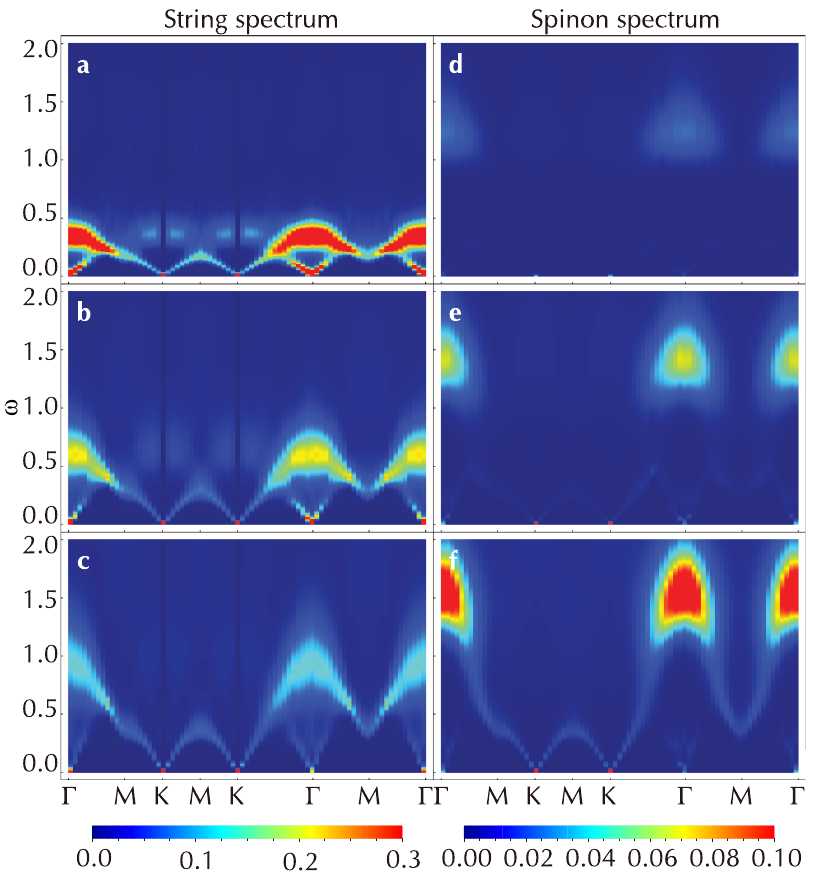
Fig. 4 The separated spectra of string excitations and spinon excitations. String spectra ( a – c ) and spinon spectra ( d – f ) with L = 24 and T = 1/96 at Δ = 0.20, J ′ = 0.020 ( a , d ), Δ = 0.35, J ′ = 0.035 ( b , e ) and Δ = 0.050, J ′ = 0.050 ( c , f